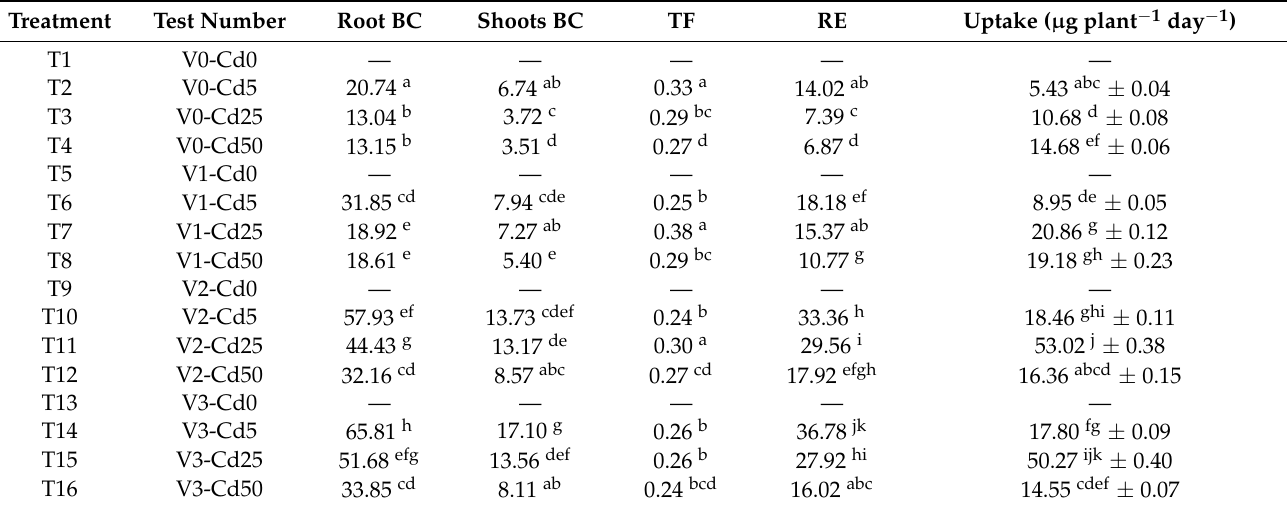
Table 2. The effect of electric field on Cd hyperaccumulation characteristics of L. japonica .